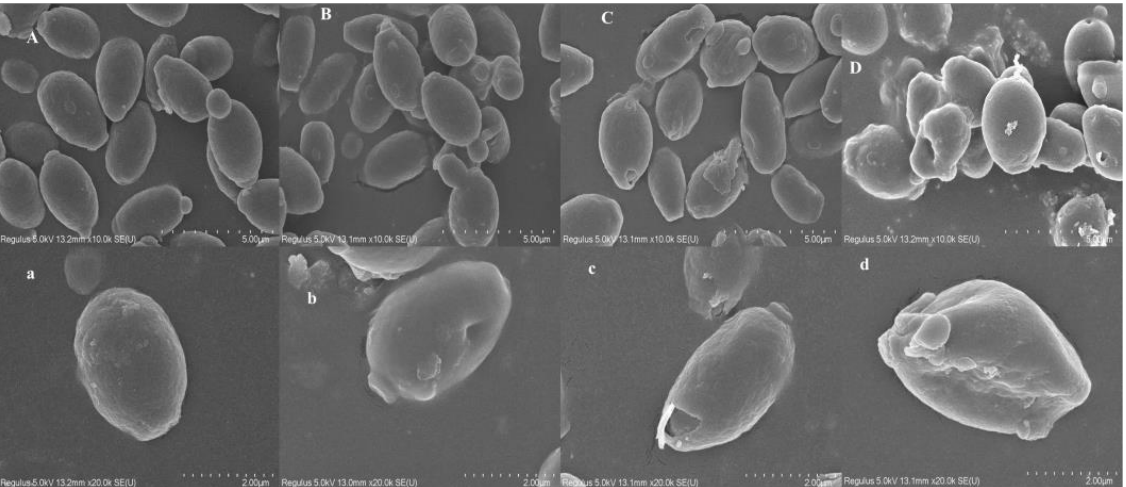
Figure 3. SEM images of P. anomala NCU003 under different ethanol stress concentrations (( A ), ( a ): control; ( B ), ( b ): 3% ethanol; ( C ), ( c ): 6% ethanol; ( D ), ( d ): 9% ethanol; ( A – D ): 10×; ( a – d ): 20×).